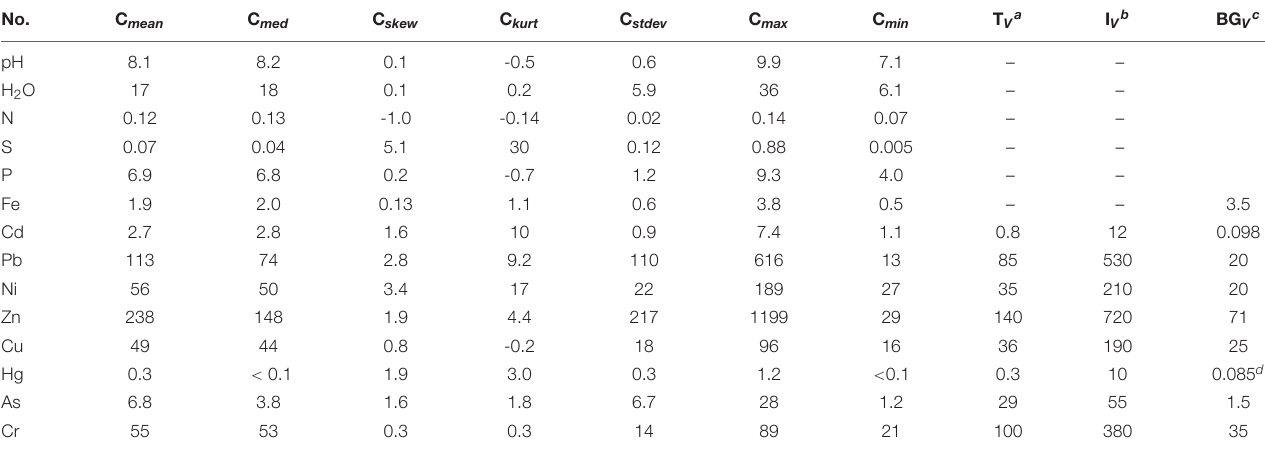
TABLE 2 | Descriptive statistics of soil samples ( n = 80) (H 2 O, N, S, Fe in %, and all others are in mg/kg).